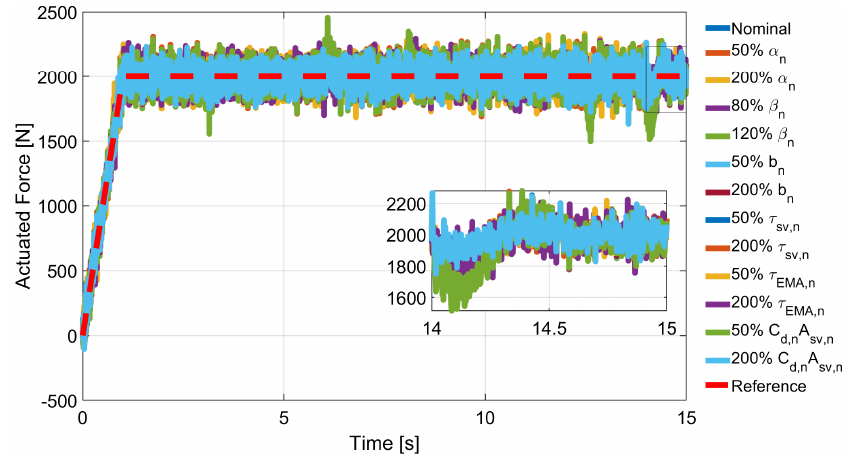
Figure 11. Simulation #2: Force actuated by the Hydraulic cylinder compared to the reference signal.